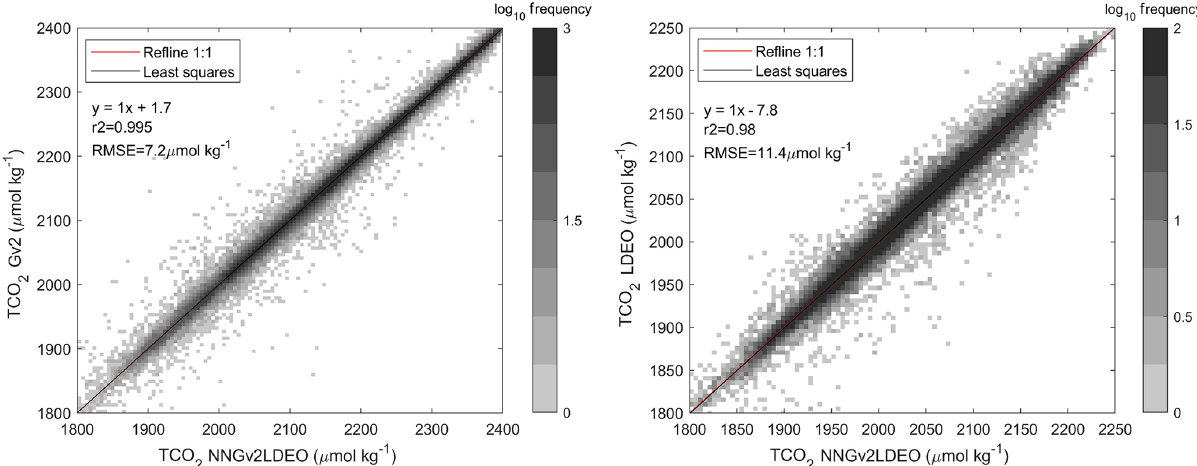
Figure 2. Regression of TCO 2 computed using NNGv2LDEO and TCO 2 in Gv2 and the LDEO dataset. The graph is divided into pixels. The color of each pixel is determined by the number of points inside it. Note the logarithmic scale of the pixels accounting for the large number of data.